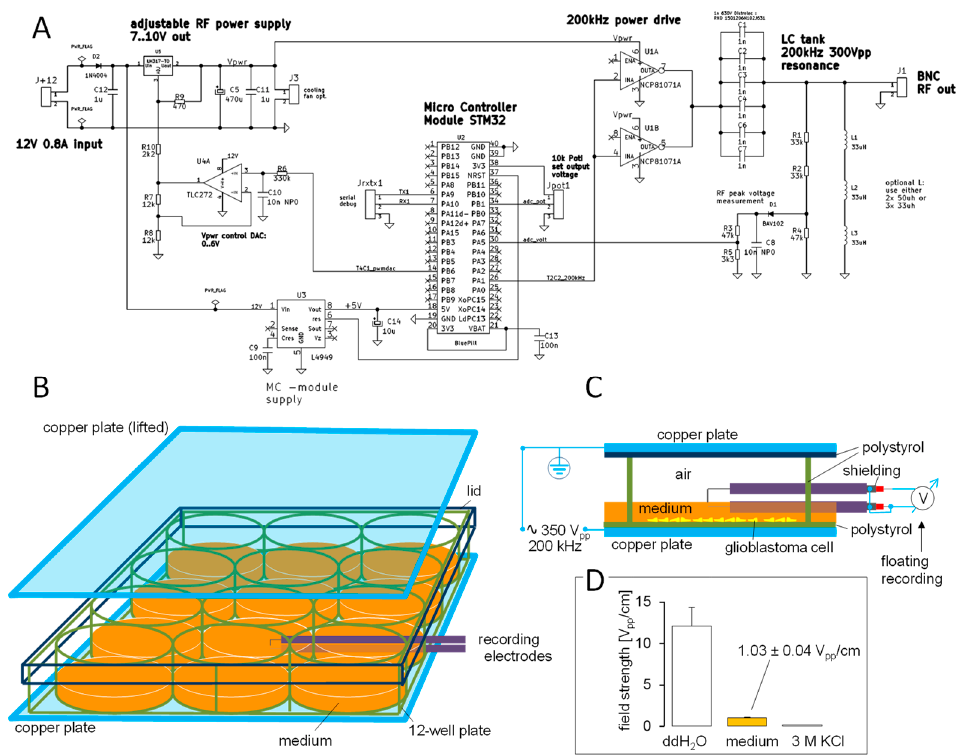
Figure 6. Cell culture TTFields applicator. ( A ) Circuitry of applicator. Frequency and amplitude